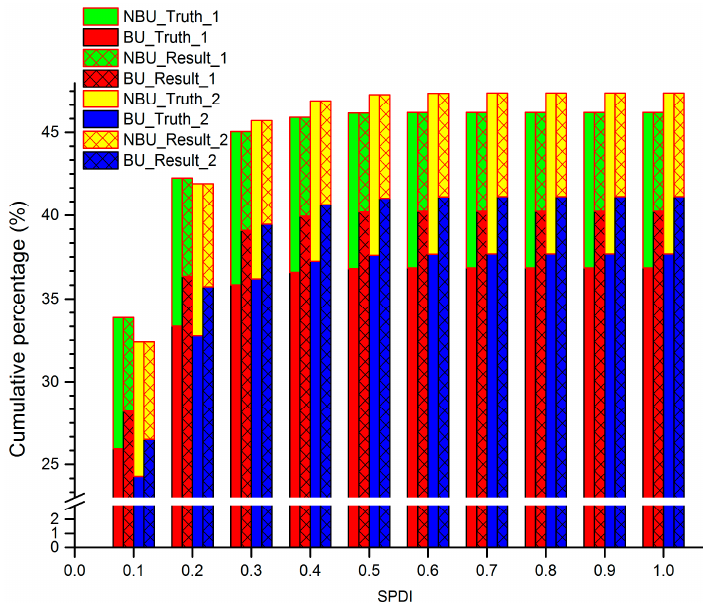
Figure 13. SPDI comparison for stereo pair 2.